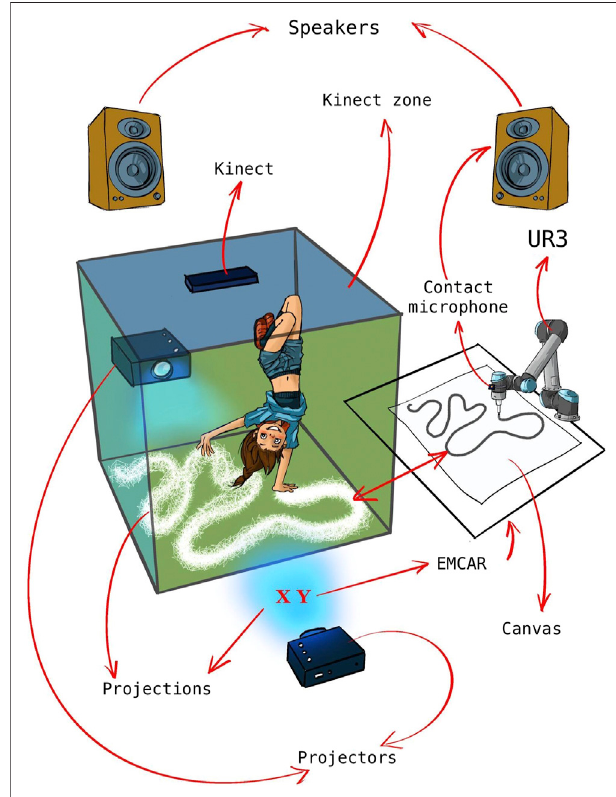
FIGURE 10 | Overview of the fi nal of the system and implementation details for the live performance. A projector mounted on the ceiling projected real-time video capture from the performance from four different angels (including a camera mounted directly on the robot) on one wall in the gallery space. Two fl oor mounted projectors using sensor data from the cameras and projected lines that corresponded to the movement patterns of the dancer with lines on the fl oor.